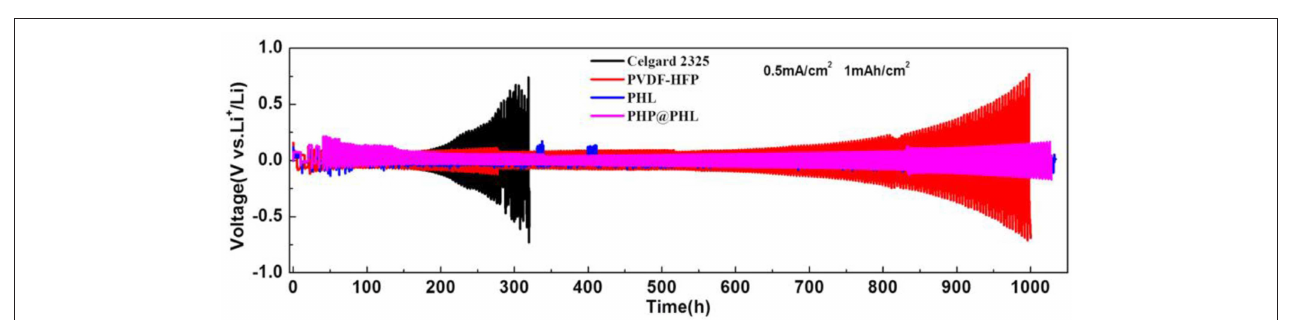
FIGURE 4 | Galvanostatic cycling performances of symmetric lithium cells with the Celgard 2325, PVDF-HFP, PHL, and PHP@PHL separators at a current density of 0.5 mA/cm 2 at 25 ◦ C.